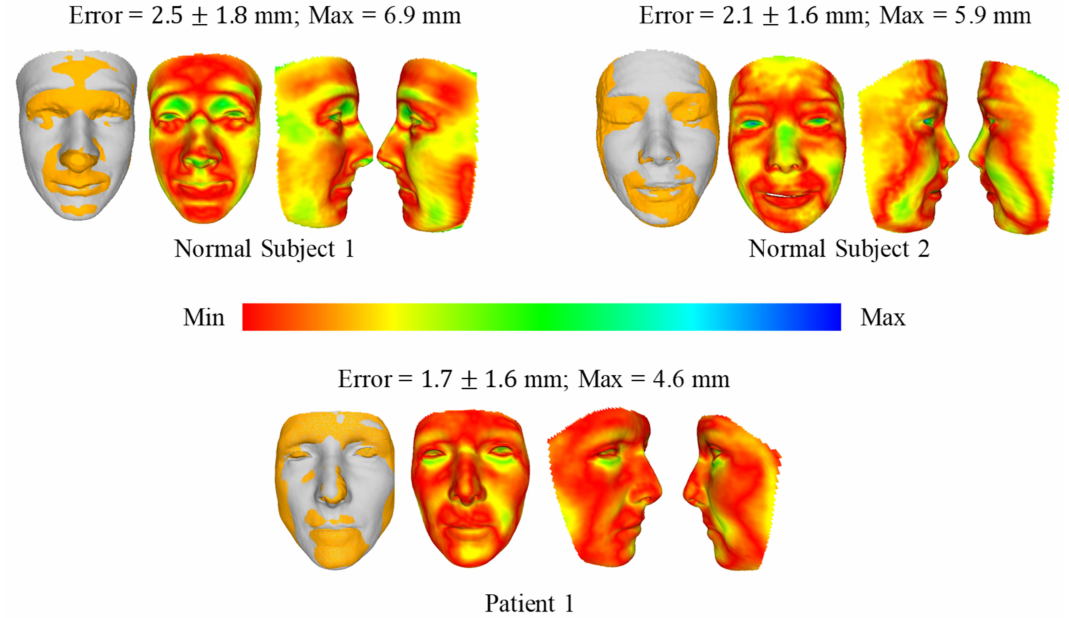
Figure 8. Comparison of 3D face reconstruction (grey) and 3D face reconstruction from MRI (yellow) using the second method